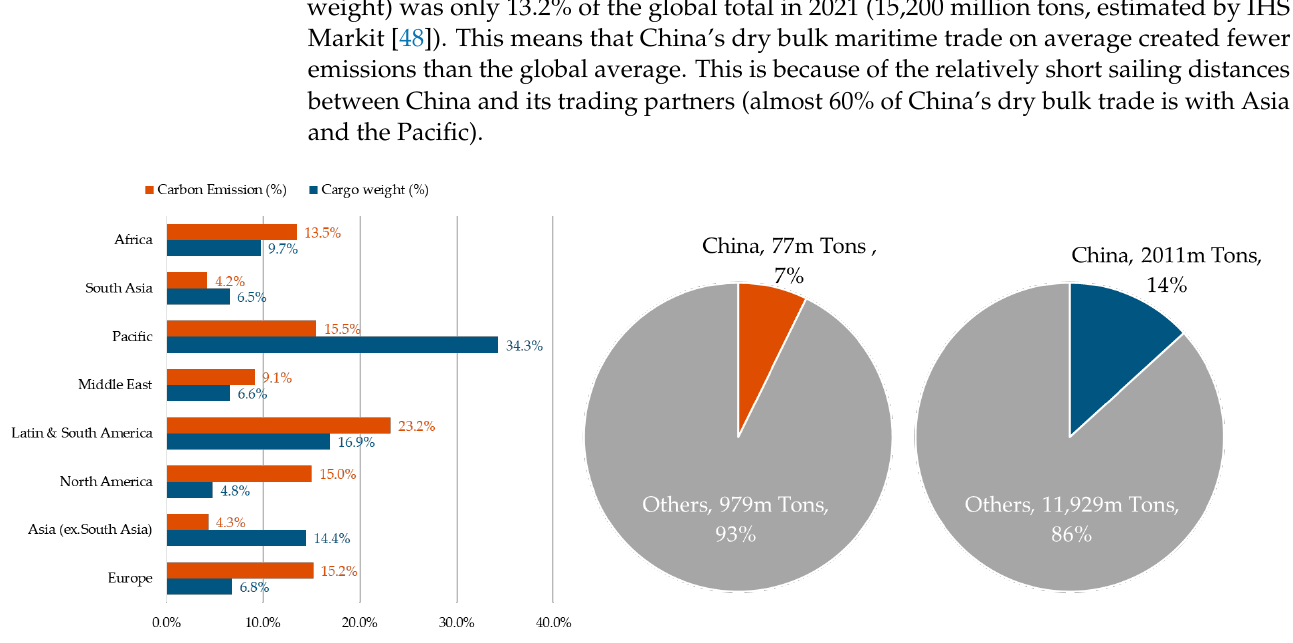
Figure 2. Comparison of China’s dry bulk trade volumes and carbon emissions in different trading regions ( left ) and global international shipping ( right ). Source: Four IMO GHG Study 2020; IHS Markit.